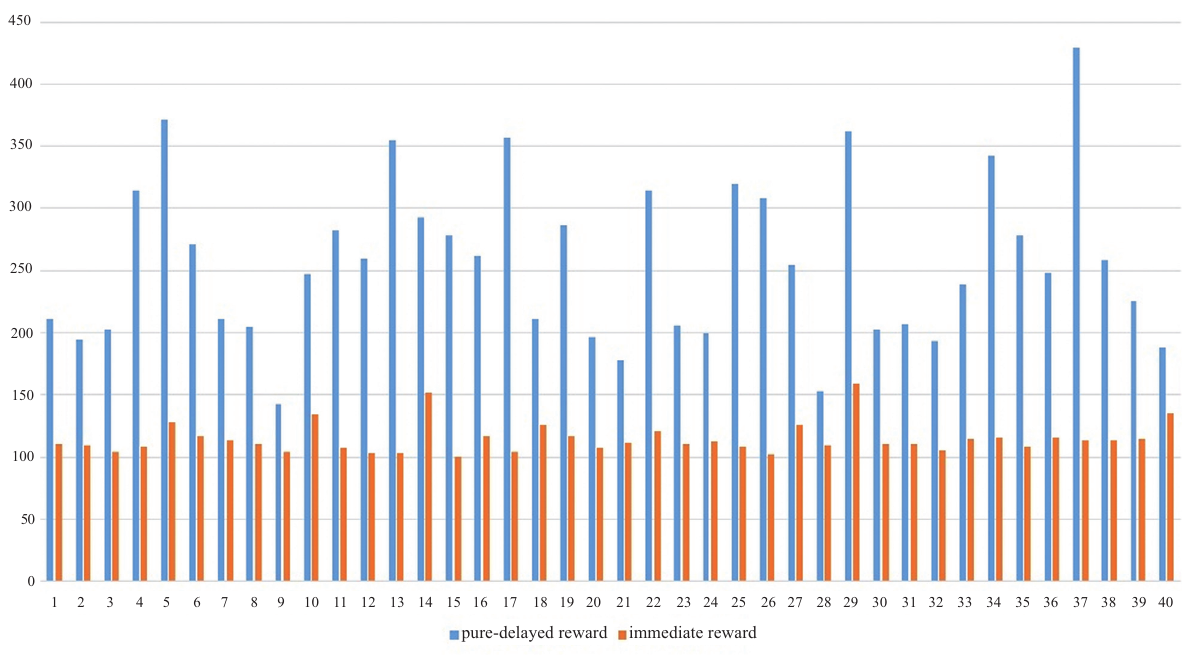
Fig. 2. Distribution of the number of training steps for two reward schemes when 𝑛 = 6.